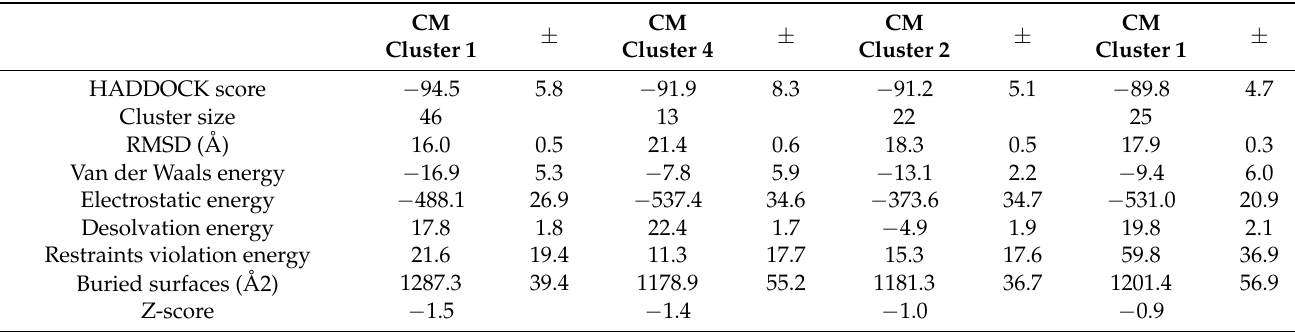
Table 1. HADDOCK docking statistics for the two best clusters for the AQP5 C-terminus modeled by Comparative Modeling ( CM ) TrRosetta . All energies are given in kcal/mol. Root-mean-square deviation (RMSD) is calculated in relation to the overall lowest-energy structure of the cluster. The Z-score indicates how many standard deviations from the average the cluster is in terms of score (the more negative, the better).